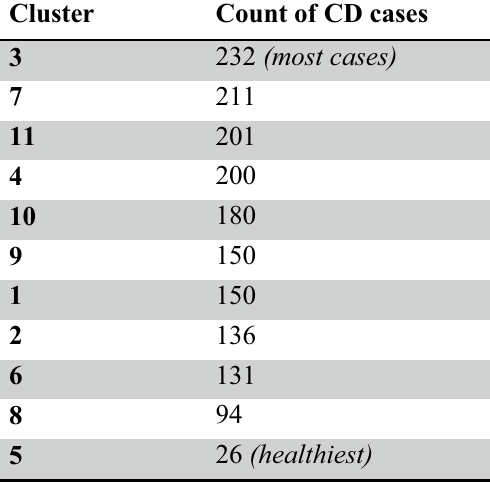
Table 2 Summary of CD counts within every cluster (descending order) Cluster Count of CD